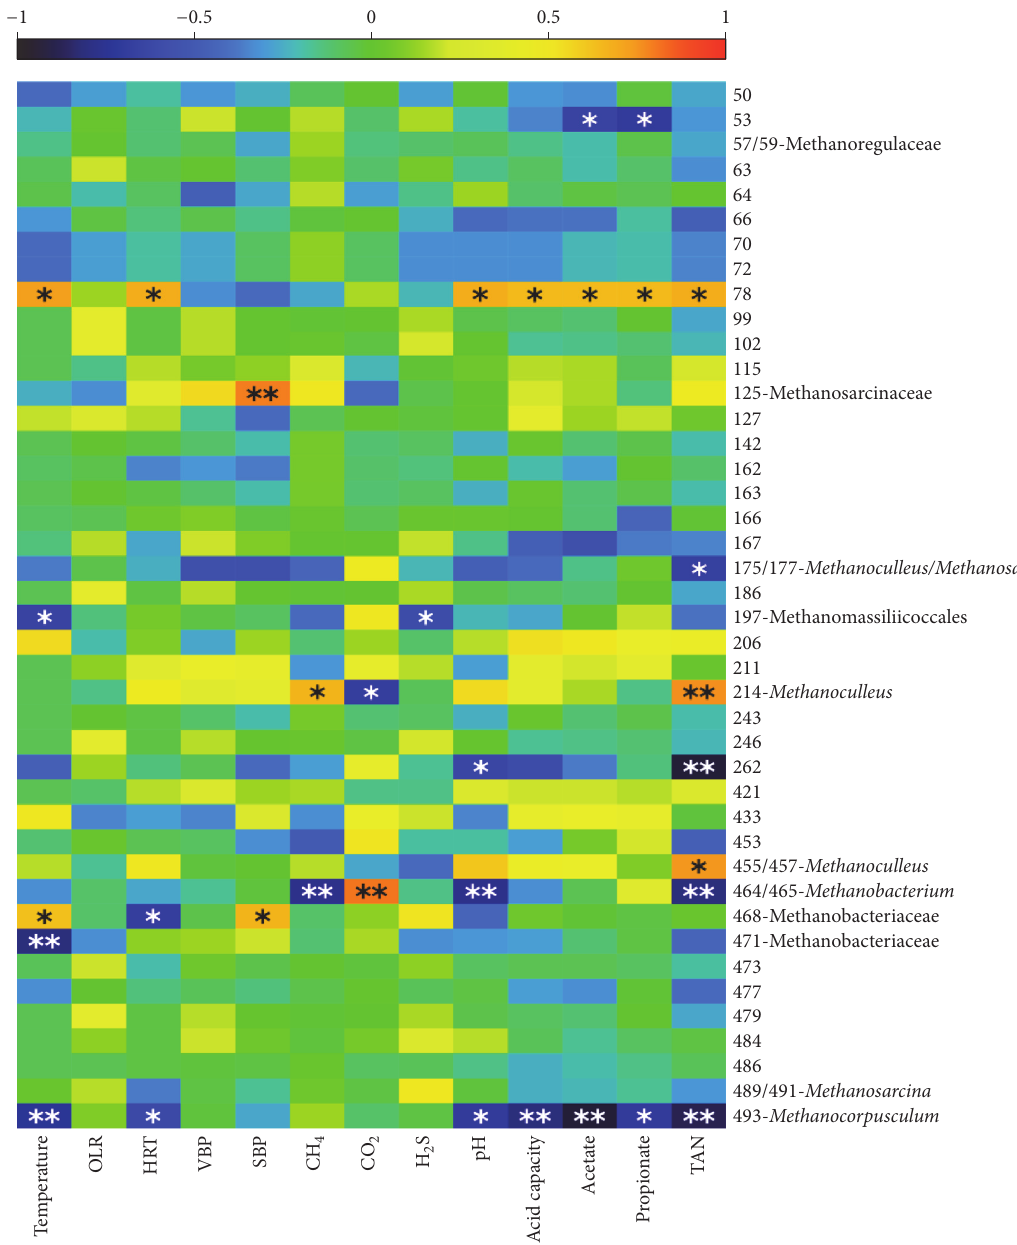
Figure 4: Correlations between the abundance of different taxa and various process parameters in biogas reactors’ samples. Spearman’s correlation coefficients are shown by color ranging. Negative correlations are displayed in blue color while positive correlations are displayed in red color. Significant correlations are indicated by ∗ 𝑝 < 0.01 and ∗∗ 𝑝 < 0.001